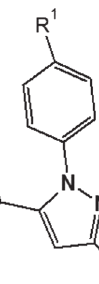
FIGURE 2 - Generic 1,5-diaryl-3-substituted-pyrazole selective COX-2 structure based on the structure of celecoxib (R 1 = SO NH , R 2 = CF , R 3 = CH 2 2 3 3